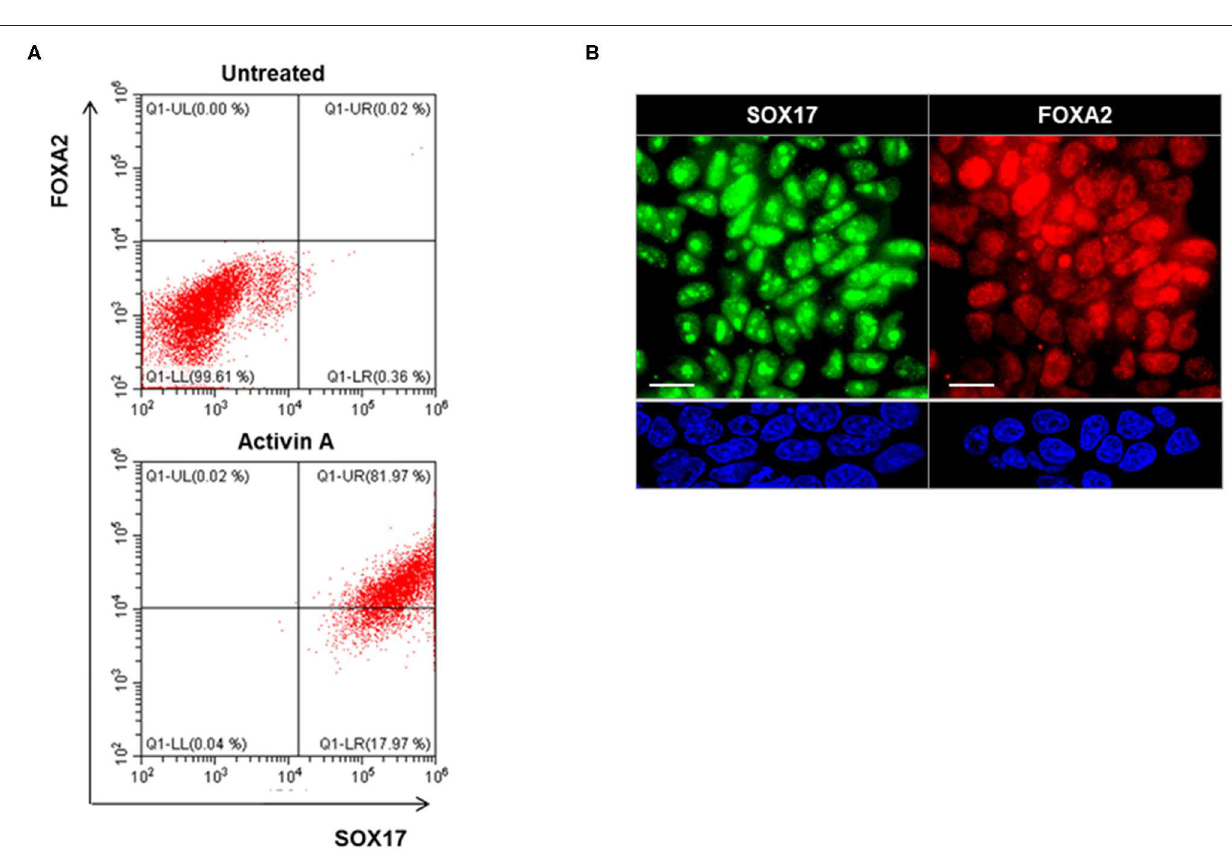
Frontiers in Endocrinology |